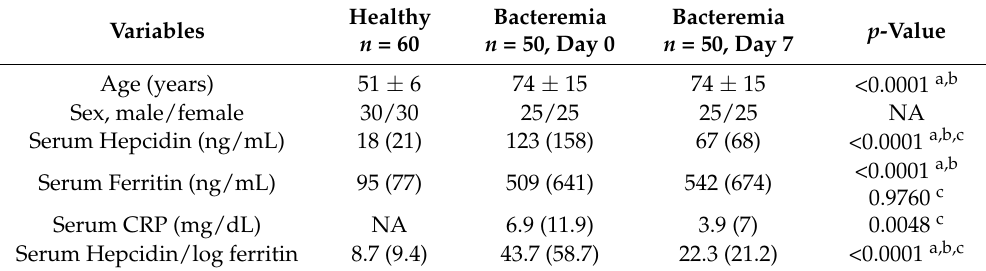
Table 1. Demographic and clinical characteristics of healthy controls and patients with bacteremia on day 0 and day 7 after appropriate treatment. Values are expressed as the mean ± SD or median (IQR). Healthy Bacteremia Bacteremia p -Value Variables n = 60 n = 50, Day 0 n = 50, Day 7 Age (years) 51 ± 6 74 ± 15 74 ± 15 <0.0001 a,b Sex, male/female 30/30 25/25 25/25 NA Serum Hepcidin (ng/mL) 18 (21) 123 (158) 67 (68) <0.0001 a,b,c <0.0001 a,b Serum Ferritin (ng/mL) 95 (77) 509 (641) 542 (674) 0.9760 c Serum CRP (mg/dL) NA 6.9 (11.9) 3.9 (7) 0.0048 c Serum Hepcidin/log ferritin 8.7 (9.4) 43.7 (58.7) 22.3 (21.2) <0.0001